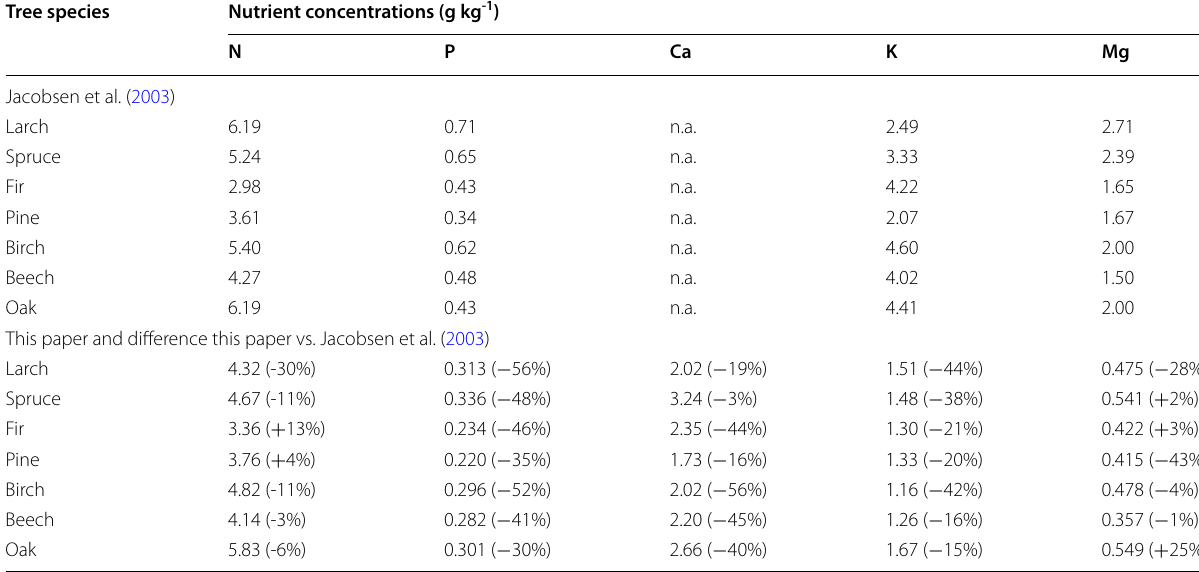
Table 12 Average nutrient concentrations (g kg -1 ) in branches, assuming larger proportions of fine branch wood (x 1.25) and bark in coarse branch wood (x 1.5), according to this paper and Jacobsen et al. (2003) and relative difference (%) between both datasets (% difference (this paper/Jacobsen et al. – 1) x 100%) =